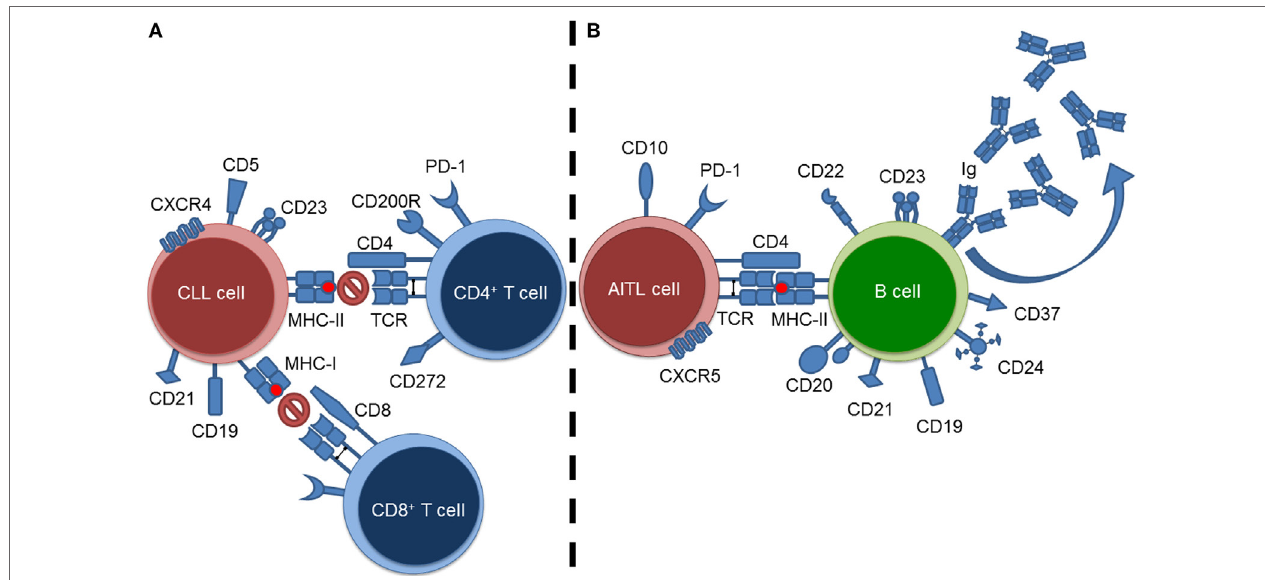
FigURe 1 | Summary of tumor–lymphoid interactions in chronic lymphocytic leukemia (CLL) and angioimmunoblastic T-cell lymphoma (AiTL) . (A) CLL cell–resident T cell interactions exemplified by blockade of T-cell-mediated responses against the CLL cells. (B) AITL cell–resident B cell interactions exemplified by stimulation of B cells resulting in